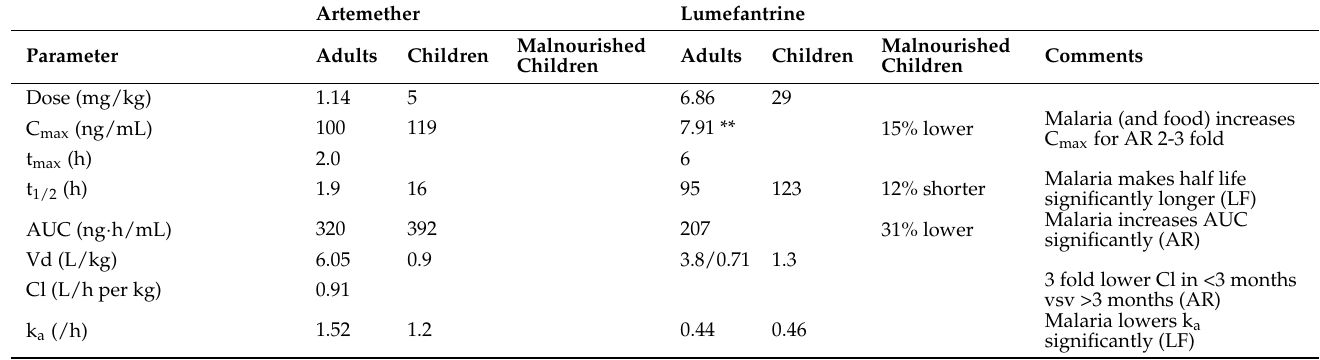
Table 2. The pharmacokinetic parameters for artemether and lumefantrine, based on values obtained from the World Health Organization (Guidelines for treatment of malaria, 3rd edition) and